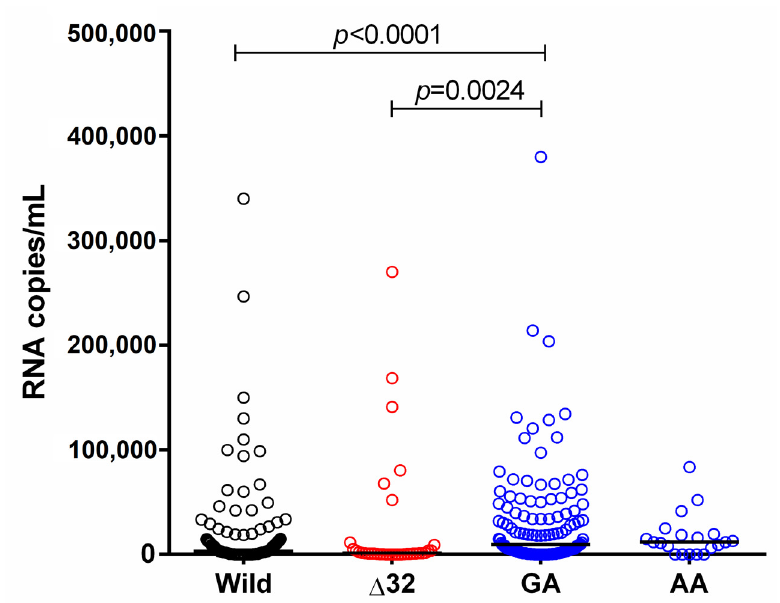
Figure 5. Plasma viral load of HIV-1 in the groups with the different genotypes of the CCR5 ∆ 32 and SDF1-3 ′ A gene variants.